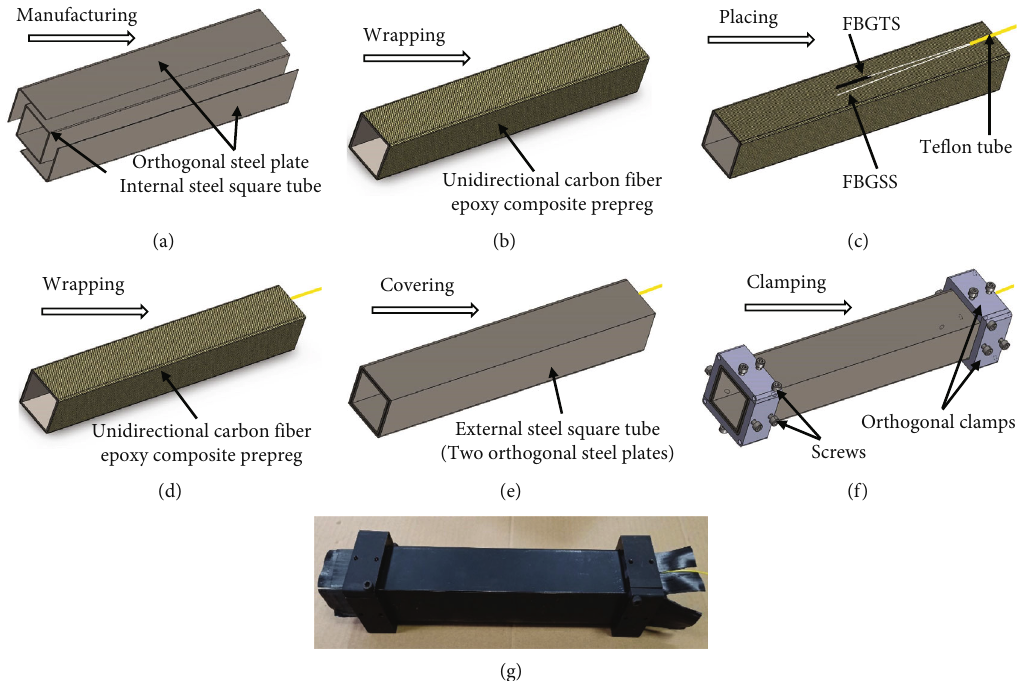
Figure 4: Fabrication processes for the hybrid HST with sandwich walls: (a) manufacturing, (b) wrapping, (c) placing, (d) wrapping, (e) covering, (f) clamping, and (g) photograph of the clamped hybrid HST.